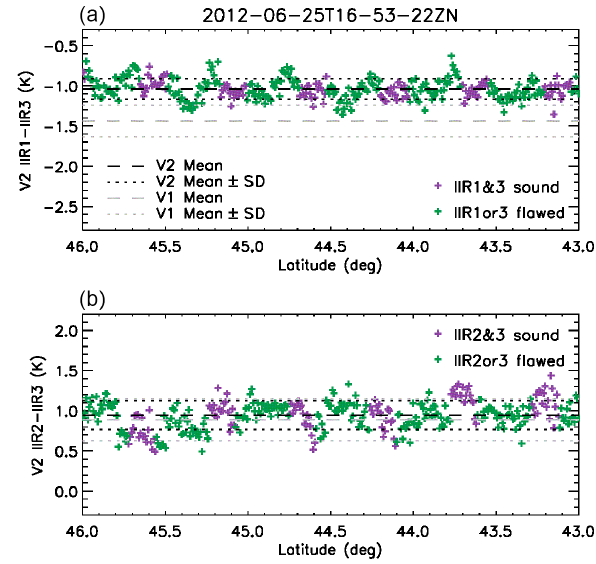
Figure 12. Version 2 IIR1-IIR3 (a) and IIR2-IIR3 (b) inter-channel BTDs in the same nighttime descending portion of the same orbit as in Figs. 3, 6, and 11. Purple: sound rows in both channels; green: flawed rows in at least one channel. The horizontal lines show the mean value (dashed) and mean value ± standard deviation (dotted) in Version 2 (black) and in Version 1